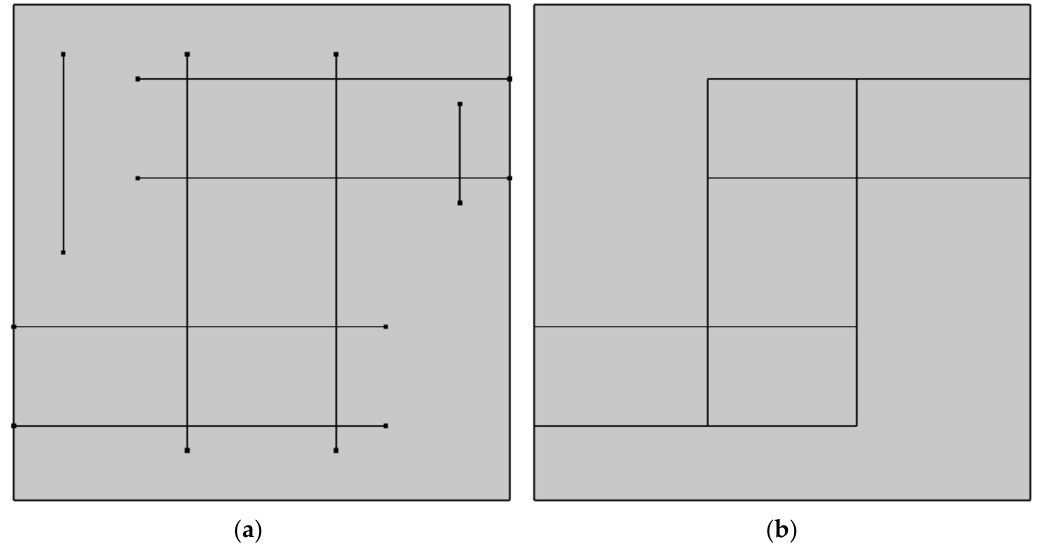
Figure 1. An original fracture network and the extracted backbone fracture network: ( a ) Original network. ( b ) Backbone network.